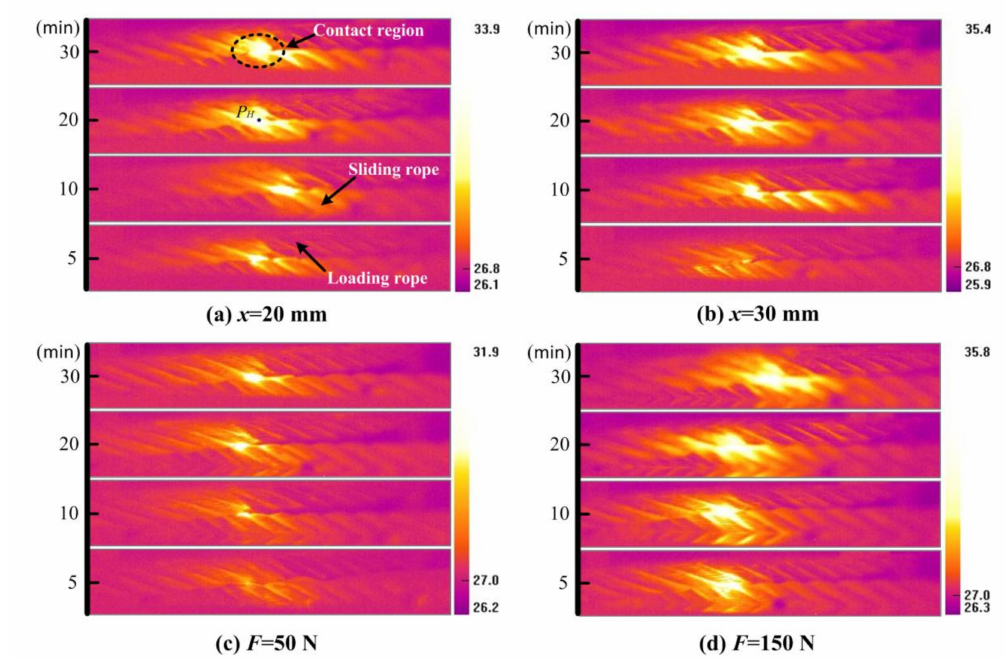
Figure 6. Infrared thermograms of contact wire ropes at different stages. ( a ) Stroke: 20 mm, load: 100 N; ( b ) stroke: 30 mm, load: 100 N; ( c ) load: 50 N, stroke: 20 mm; ( d ) load: 150 N, stroke: 20